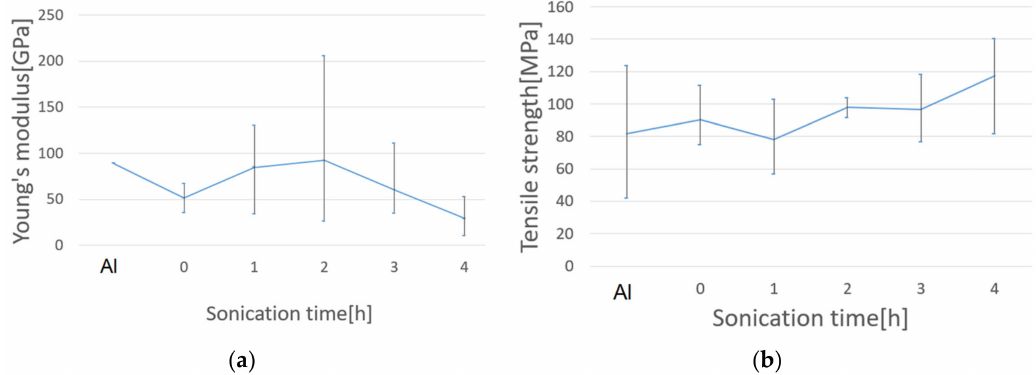
Figure 11. Young’s modulus ( a ) and tensile strength ( b ) as a function of sonication time for the Al and 0.5 mass.% CNT / Al composites.